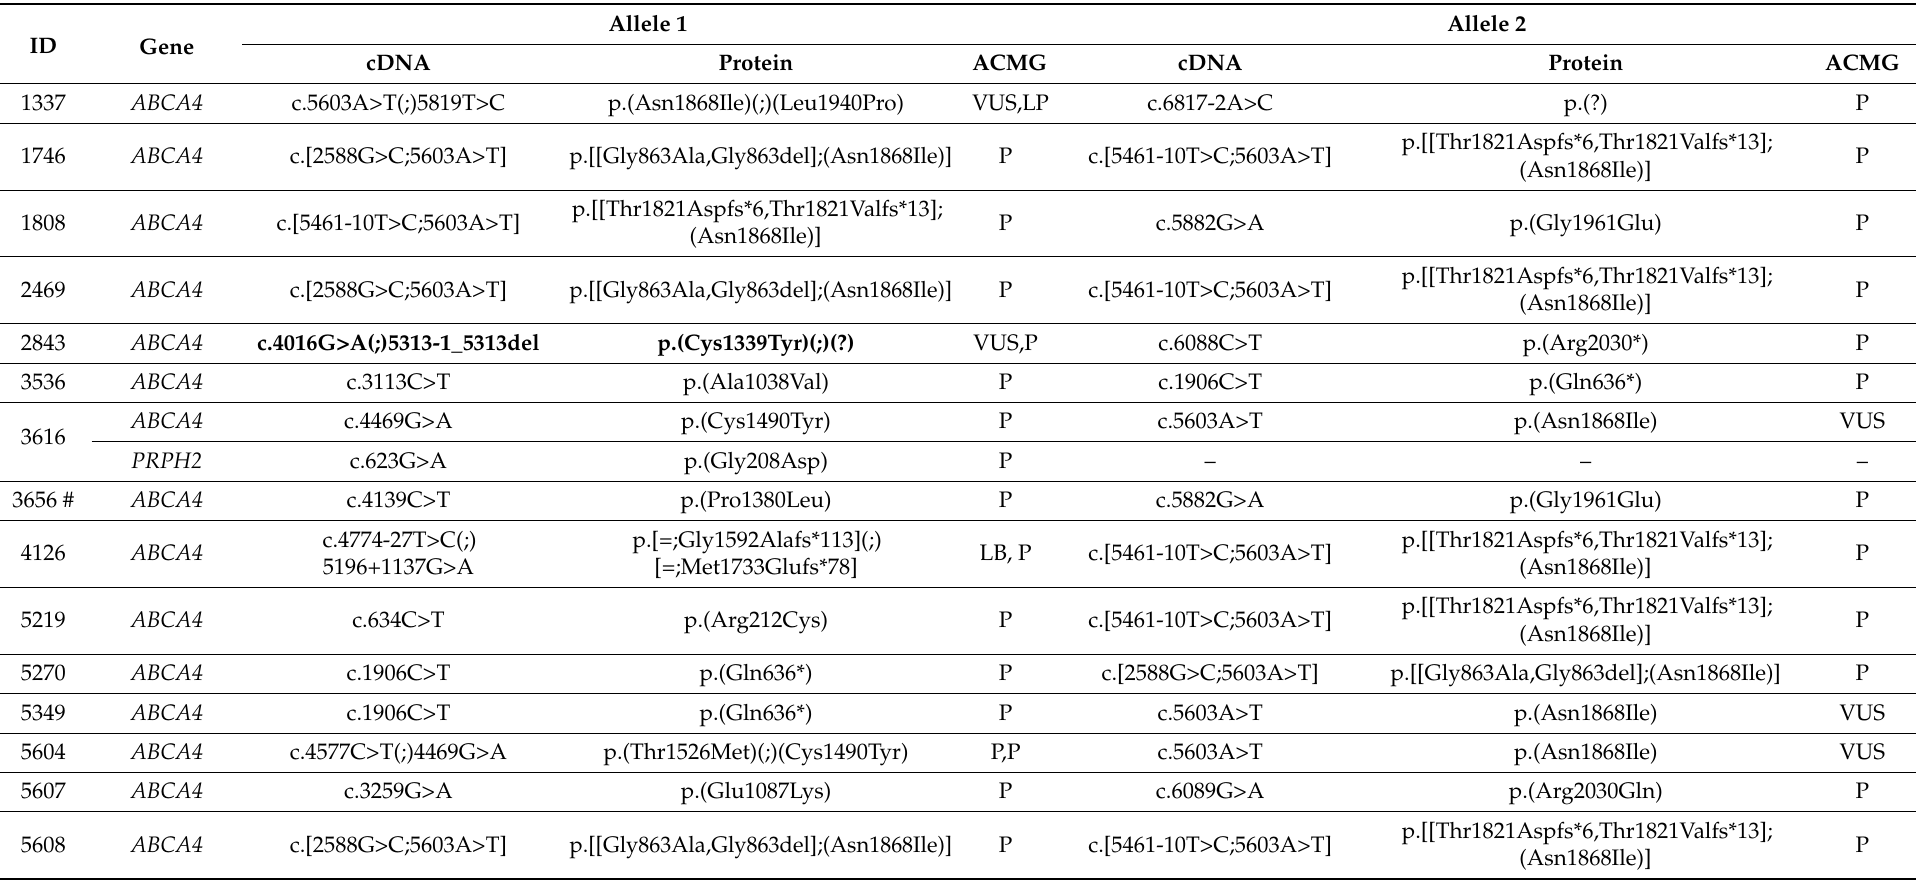
Table 1. Identified variants considered to very likely or possibly solve probands. Novel variants are highlighted in bold text. As no segregation analysis was performed, variants were distributed on two alleles from 5’ to 3’ considering proximity. When variants c.5461-10T>C and c.5603A>T, or variant c.2588G>C and c.5603A>T were found in the same patient, they are reported as complex alleles, as they are found in these combinations in >95% of reported STGD cases. ACMG classifications were obtained using Franklin by Genoox. P = Pathogenic, LP = Likely pathogenic, VUS = Variant of uncertain significance, LB = likely benign. # = Segregation analysis was